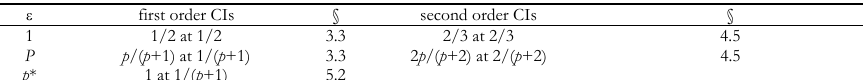
ACE rate β and α for (3) for twosided CIs 1 ( ε = for asymptotic Studentization , p ε = for